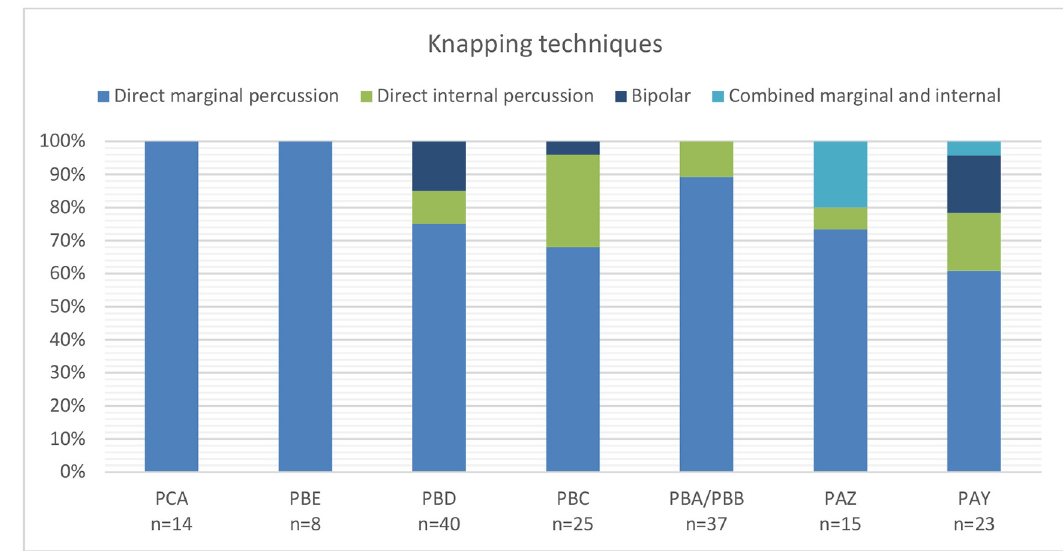
Fig 3. Knapping techniques observed on cores per